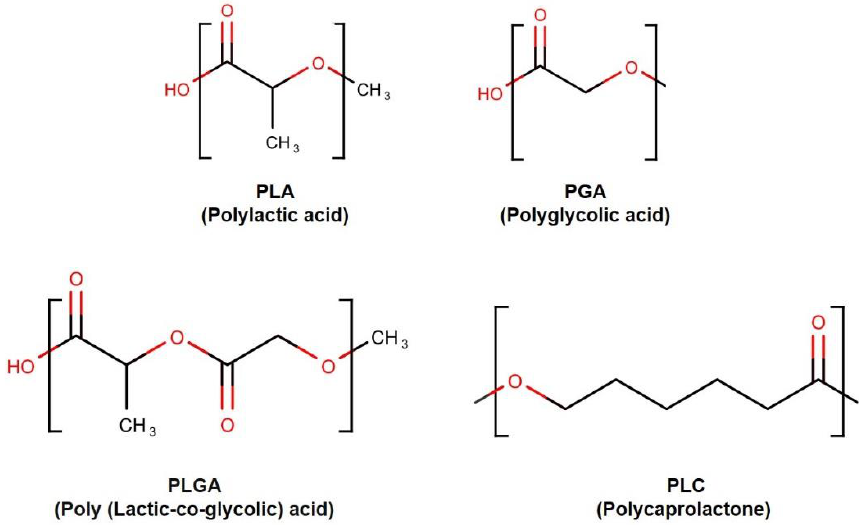
Figure 3. Synthetic bio-degradable polymer structures.